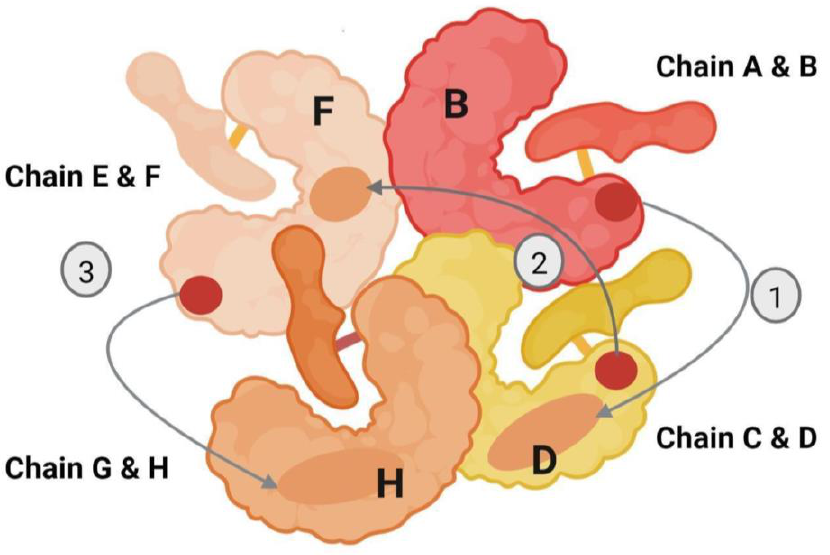
Figure 5. Pictorial representation of monomeric–dimeric correlation of the 8HGZ cryogenic structure. According to cross-correlation with GNM analysis of 8HGZ structure, the C-terminal Pro and Lys residues of chain B are highly correlated with chain D (1); the C-terminal Pro and Lys residues of chain D are highly correlated with chain F (2), and the C-terminal Pro and Lys residues of chain F are correlated with chain H (3). The 8HGZ structure composed of two dimers or four monomers; compared to 1XDA structure, the AB-CD (1st dimer) is of an extroverted form, whereas the EF-GH (2nd dimer) is of a slightly introverted form, as opposed to the 1st dimer. Based on the intrachain’s correlation, the AB monomer has at least a 75% correlation with each other (colored in red); the CD monomer and the EF monomer correlate in intrachain up to 50% (colored in yellow and wheat); the GH monomer has at least 50% correlation with each other (colored in orange).